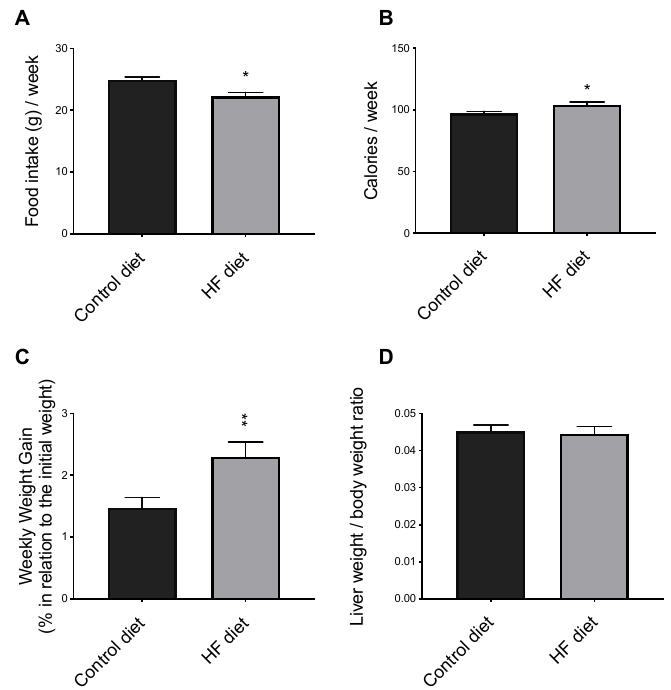
Figure 1. The effect of control and High-Fat (HF) diets on food ( A ) and calories ( B ) intake, and on animal growth ( C ) and relative liver weights ( D ). Data shown are the mean ± SEM (n = 10 per group); * p < 0.05; ** p < 0.01 control versus HF. Oil Red O staining showed that livers from HF ‐ fed mice presented more macrovesic ‐ ular lipid droplets of Oil Red O positive staining than controls (Figure 2). Ballooned hepatocytes and sinusoids capillarization, on the other hand, were also exacerbated in the HF ‐ fed mice, showing more inflated hepatocytes, as compared to the control mice, indi ‐ cating liver damage by the HF diet. This finding is consistent with a previous study, in which hepatic fat accumulation was reported in apoE − / − mice after seven weeks of a diet containing similar amounts of fat and cholesterol as the HF ‐ diet used in this study [41]. Figure 2. The effect of the experimental diets on liver morphology and hepatic lipid deposition (n = 3–4/group). The images selected as representatives are at 400× magnification. Red: neutral lipid; purple: nuclei.